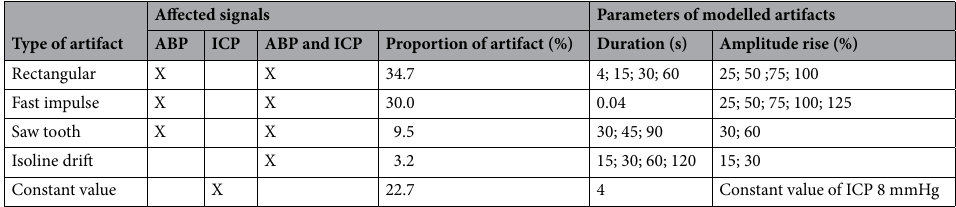
Table 1. Observed artifacts, their occurrence in arterial and intracranial pressure waveforms and parameters of simulated artifacts (duration and amplitude change).